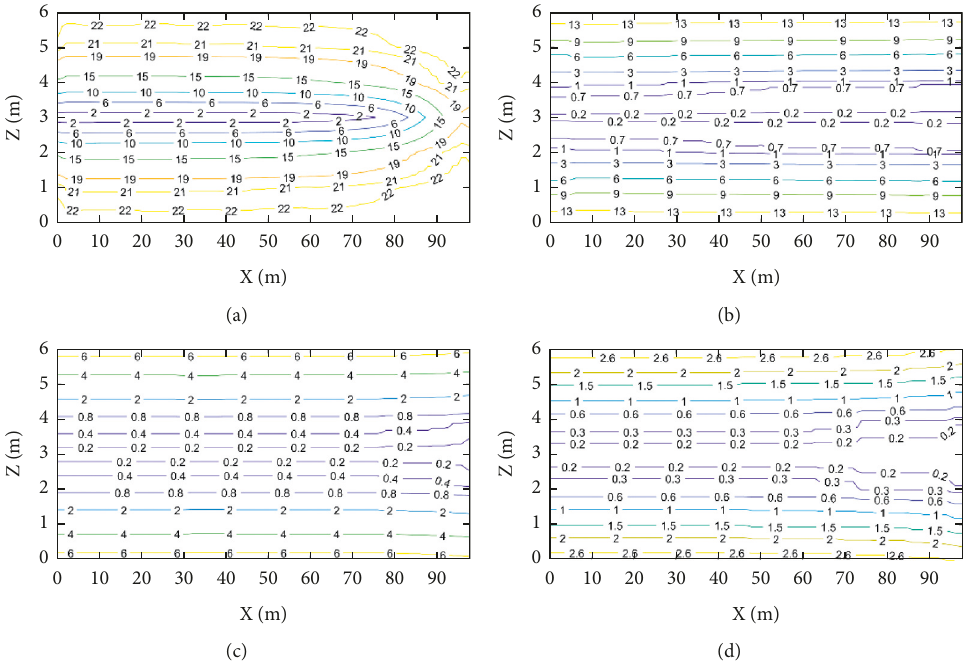
Figure 5: Simulation results of gas adsorption amount of section y